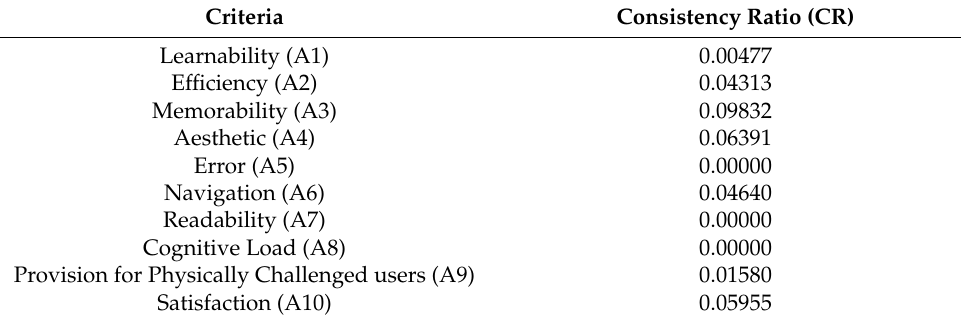
Table 15. Consistency ratio (CR) for the criteria